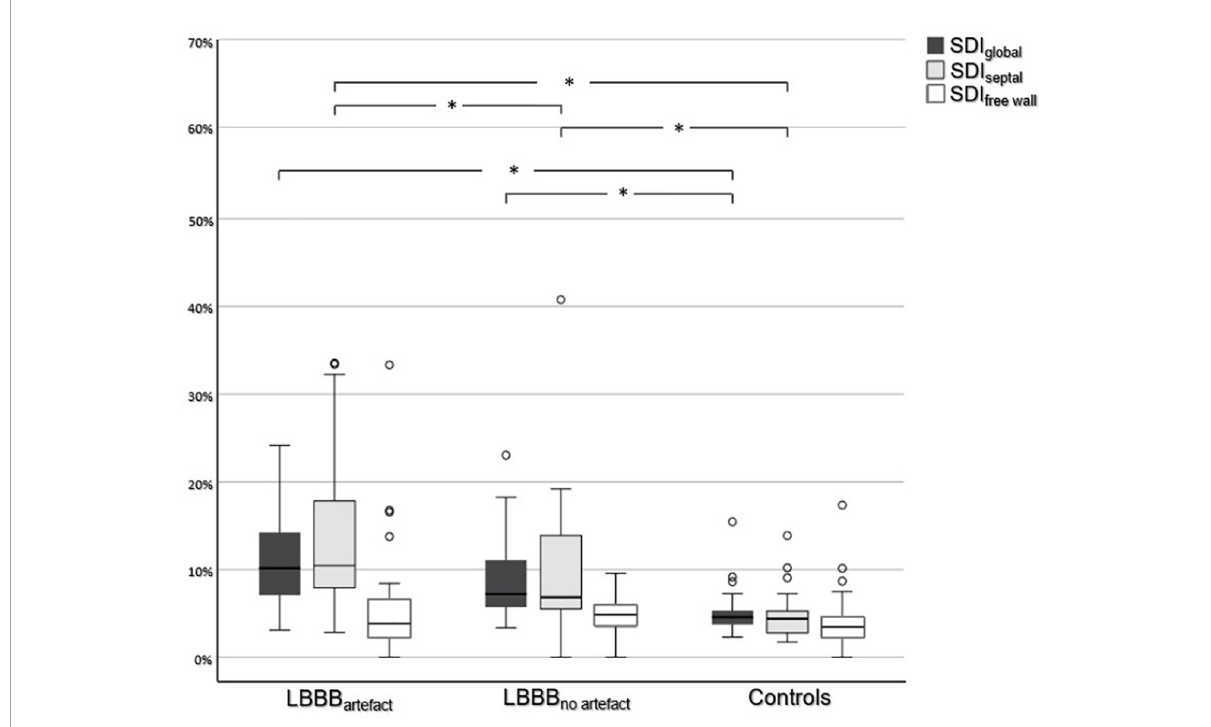
FIGURE3 Comparison of systolic dyssynchrony indices. Comparison of SDI global , SDI septal , and SDI freewall between all three subgroups. An asterisk ( ∗ ) indicates a statistically significant difference ( p <